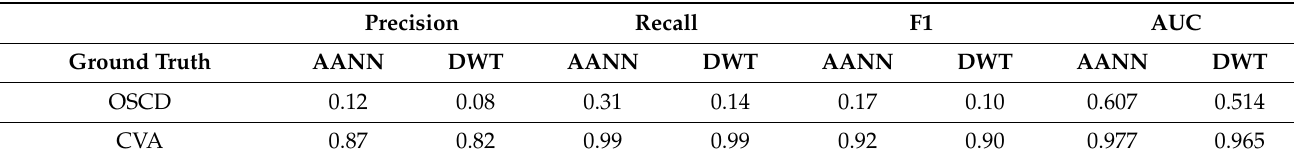
Table 3. Results for test image